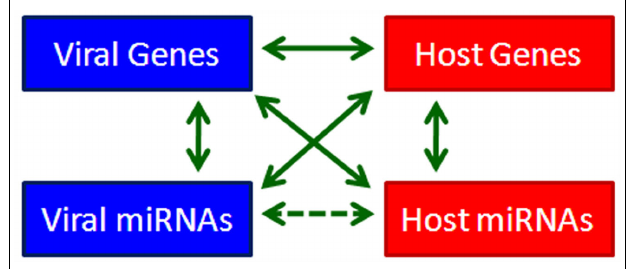
FIGURE 1 |A four-component model for viral–host interaction.